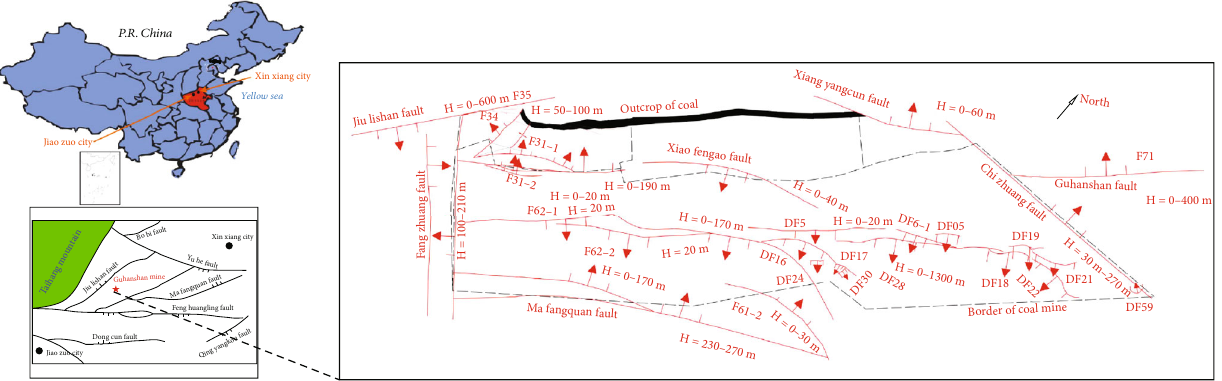
Figure 1: Regional tectonic pro fi le and sketch of mine geological